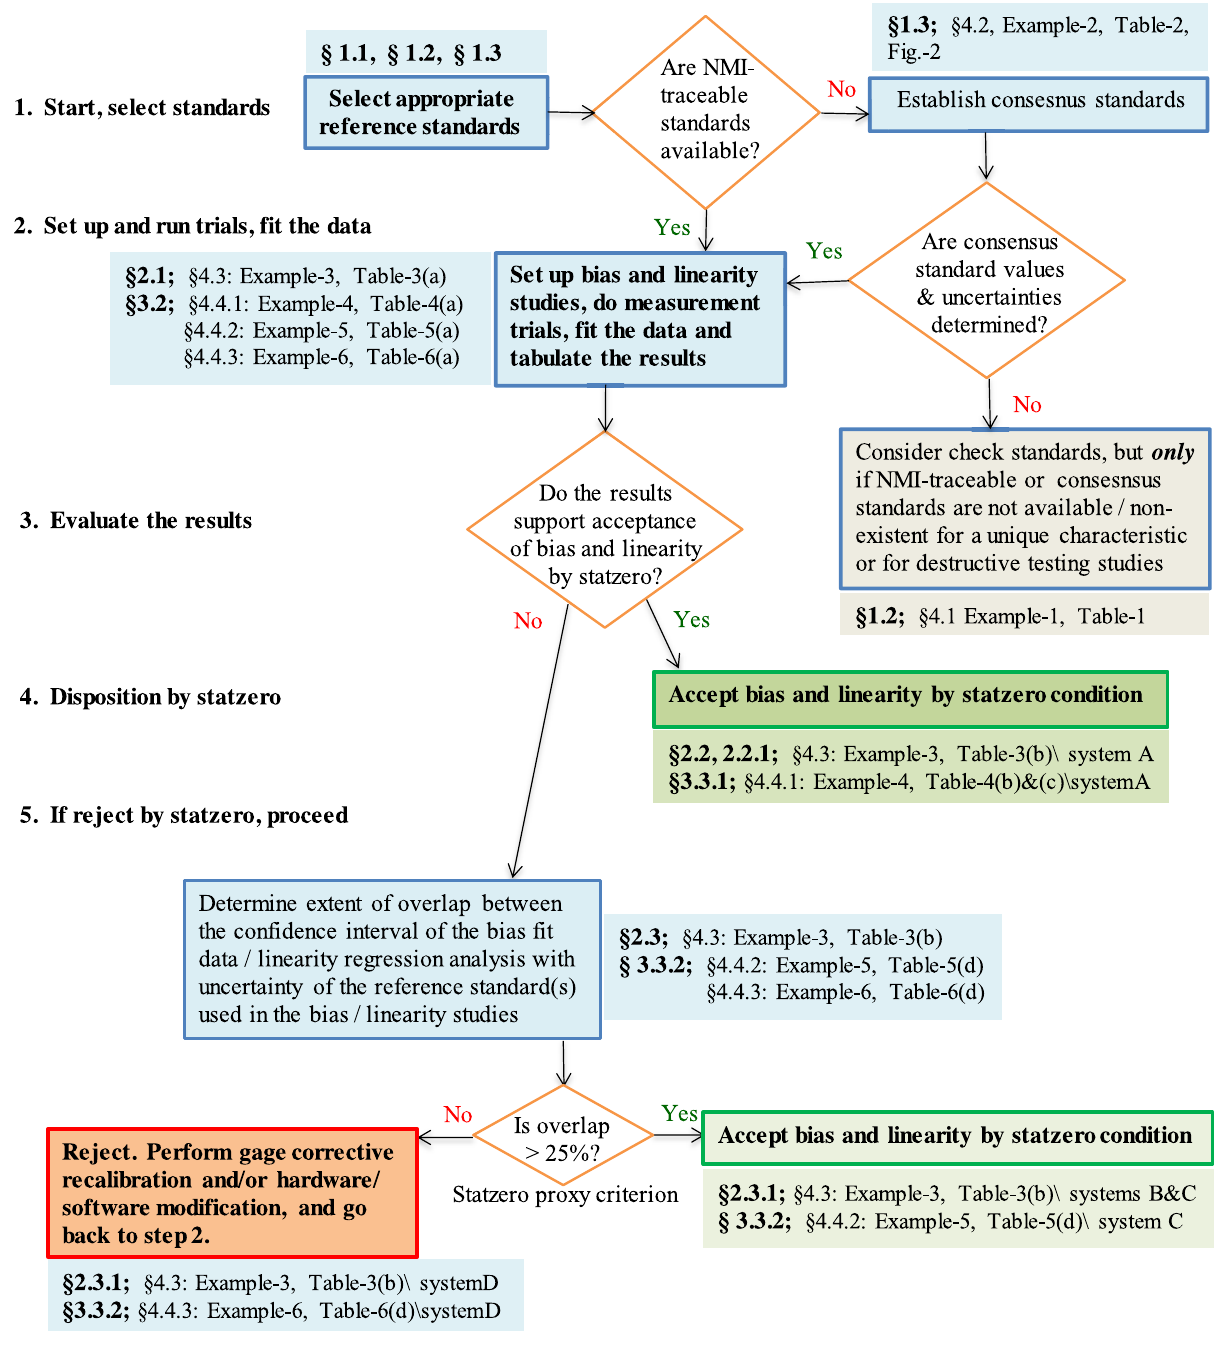
Fig. 1. Gage bias and linearity fl ow chart/decision tree (paper